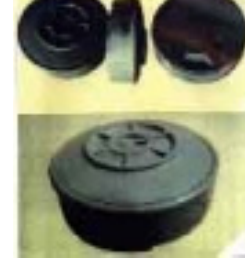
Figure 28 – YM-III mine Рис . 28 – Мина YM-III Слика 28 – Мина